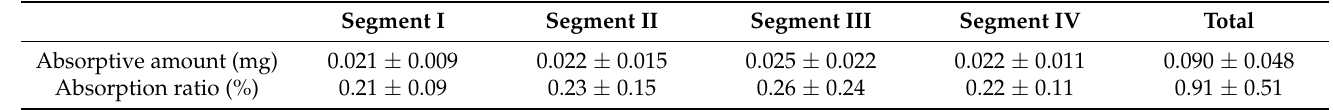
Table 3. Absorption ratio of azalomycin F in four intestinal segments ( n = 3) .